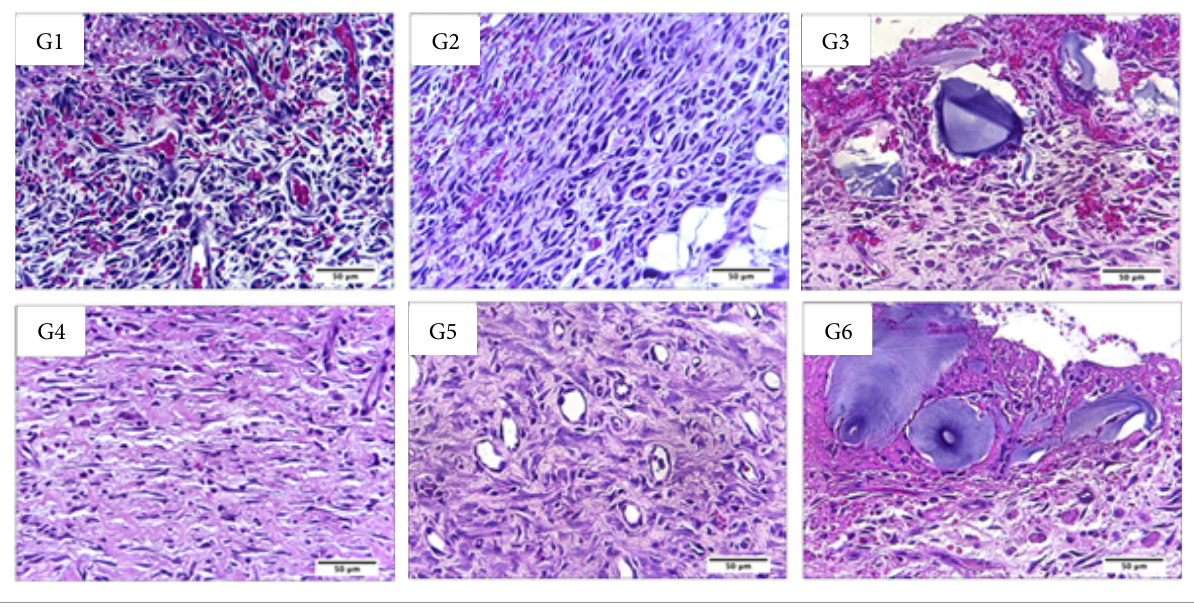
Figure 5 - Microscopic aspects of partial thickness burn wounds experimentally induced in Wistar rats seven days after the injury induction. Stain hematoxylin and eosin. Augmentation: 40x scale in μ